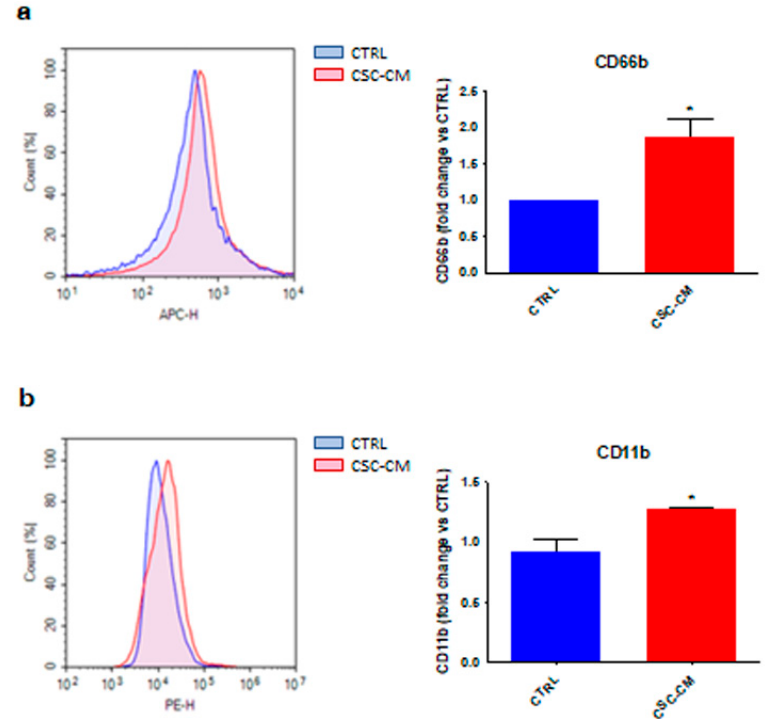
Figure 1. Melanoma SC–CM promotes the activation of neutrophils. ( a ) dHL60 cells were incubated with CSC–CM for 1 h. The expression of CD66b was evaluated by flow cytometry. Each experiment was repeated three times. Data are expressed as mean values ± SEM and were analyzed by t -test. * p < 0.05 vs. ctrl (control). ( b ) dHL60 cells were incubated with CSC–CM for 1 h. The expression of CD11b was evaluated by flow cytometry. Each experiment was repeated three times. Data are expressed as mean values ± SEM and were analyzed by t -test. * p < 0.05 vs. ctrl (control).